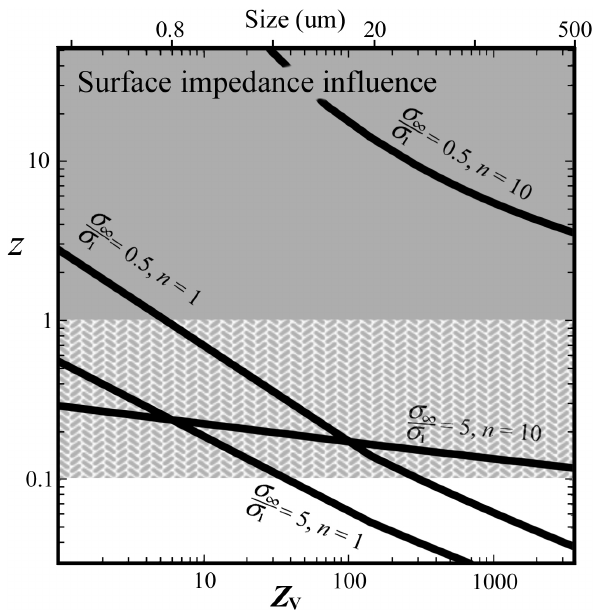
Fig. 1. Relative influence of the surface impedance for a range of vapor impedances (from Eqs. C1, C2). Each curve represents a crystal with the labeled surface parameters. Crystals in the grey zone ( z ≥ 1) likely have fractionation values significantly affected by surface processes, whereas those in the white zone ( z ≤ 0 . 1) will likely not be affected. The case for the hatched region depends on the ratio x . Crystal diameter values on the top scale assume the equation for Z V of a sphere at 1000 mbar (see Appendix